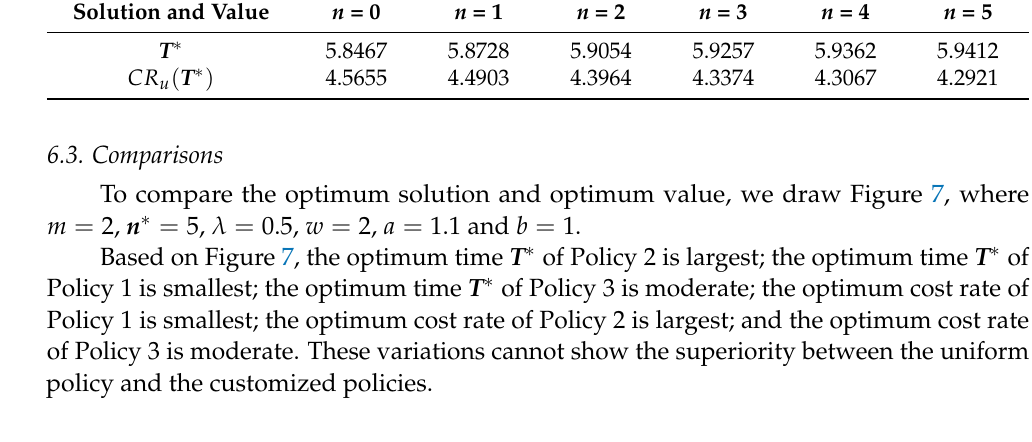
Figure 6. The post-warranty maintenance policy versus λ .